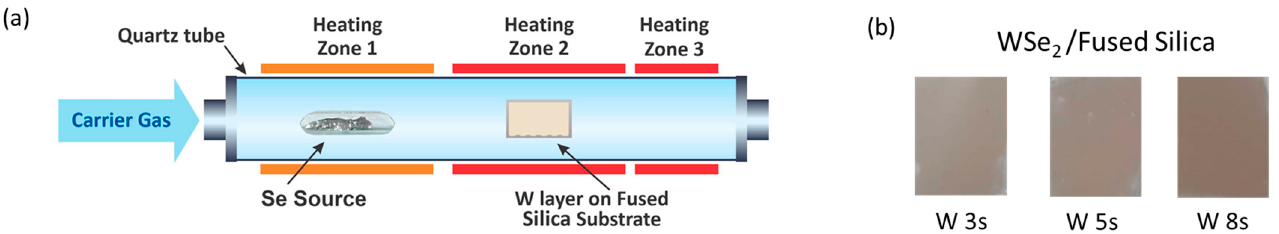
Figure 1. ( a ) CVD reactor for TAC method and ( b ) photographs of WSe 2 samples on fused silica for 3 s, 5 s and 8 s deposition time of W layers.